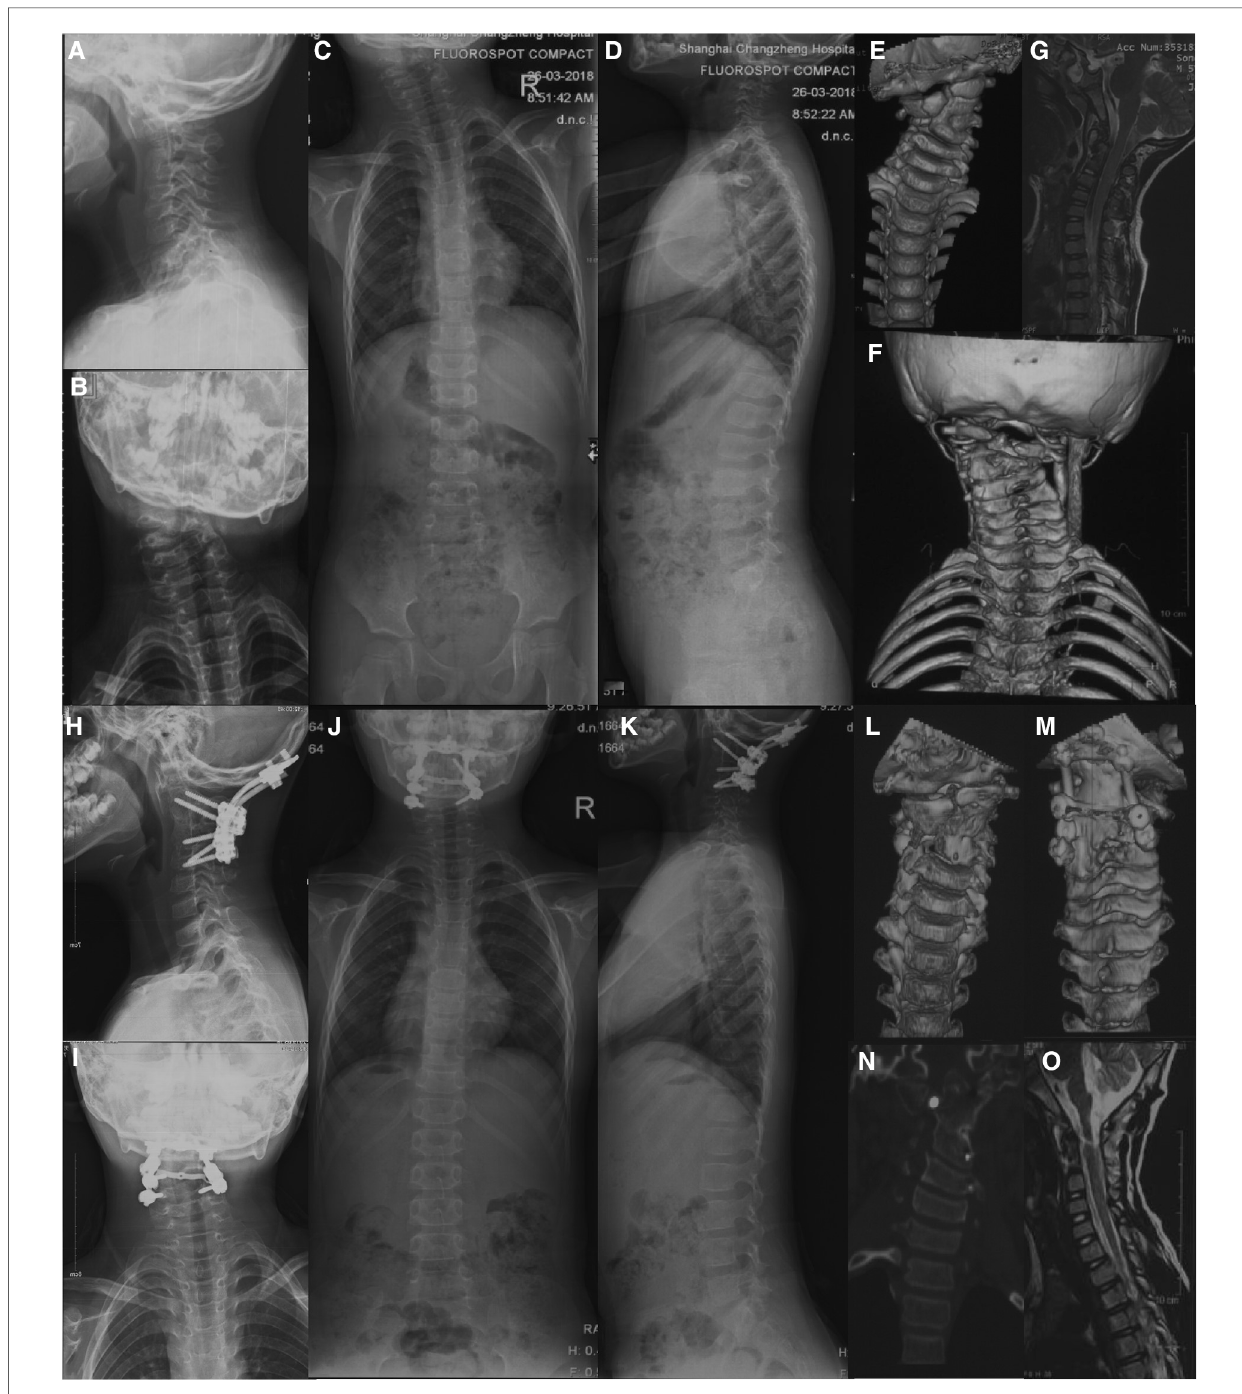
FIGURE 4 A case of Type IB cervical hemivertebra, male, 6 years old. Figures ( A – G ): C3 hemivertebrae with fusion of C2 and C4 on the concave side; Figures ( H – O ): A-P approach resection of C3 hemivertebrae, occipital-cervical fi xation and fusion, and 2-year